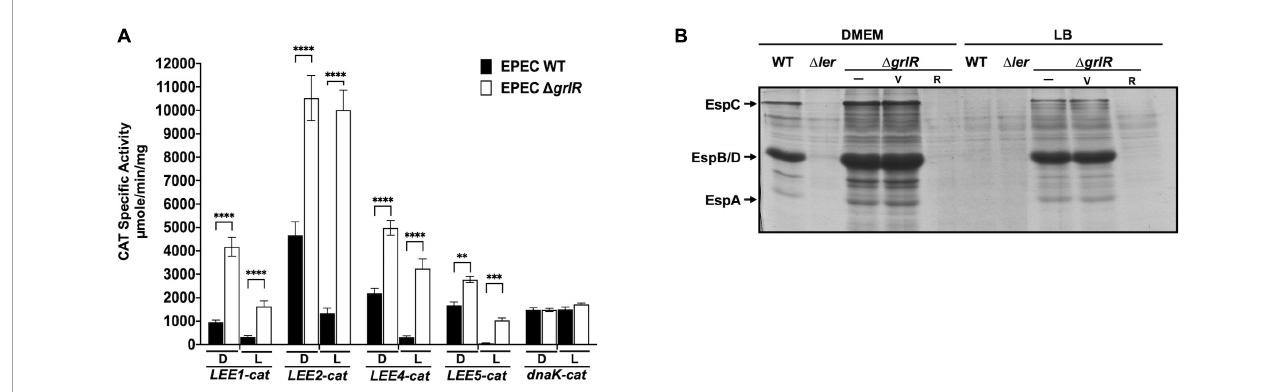
FIGURE1 The absence of GrlR derepresses the expression of locus of enterocyte effacement (LEE) operons under repressing conditions. (A) The transcriptional activity of the LEE1-cat , LEE2-cat , LEE4-cat , LEE5-cat , and dnaK-cat fusions was analyzed in WT EPEC (black bars) and its (cid:49) grlR isogenic mutant (white bars), grown in 50 ml DMEM (D) or LB medium (L) with shaking at 37 ◦ C. Specific chloramphenicol acetyltransferase (CAT) activity was determined from samples collected at an OD 600 of 1. Values are an average of three independent experiments performed in duplicate. Error bars indicate standard deviations. Statistically different values are indicated ( ∗∗ p -value < 0.01; ∗∗∗ p -value < 0.001; ∗∗∗∗ p -value < 0.0001). (B) Profile of secreted proteins of EPEC WT, (cid:49) ler and (cid:49) grlR (carrying the empty vector pMPM-T3 or its derivative pT3GrlR) grown under the same conditions as in panel (A) . Secreted proteins were concentrated from culture supernatants by precipitation with trichloroacetic acid (TCA) and separated by 12% SDS-PAGE. V: pMPM-T3, R: